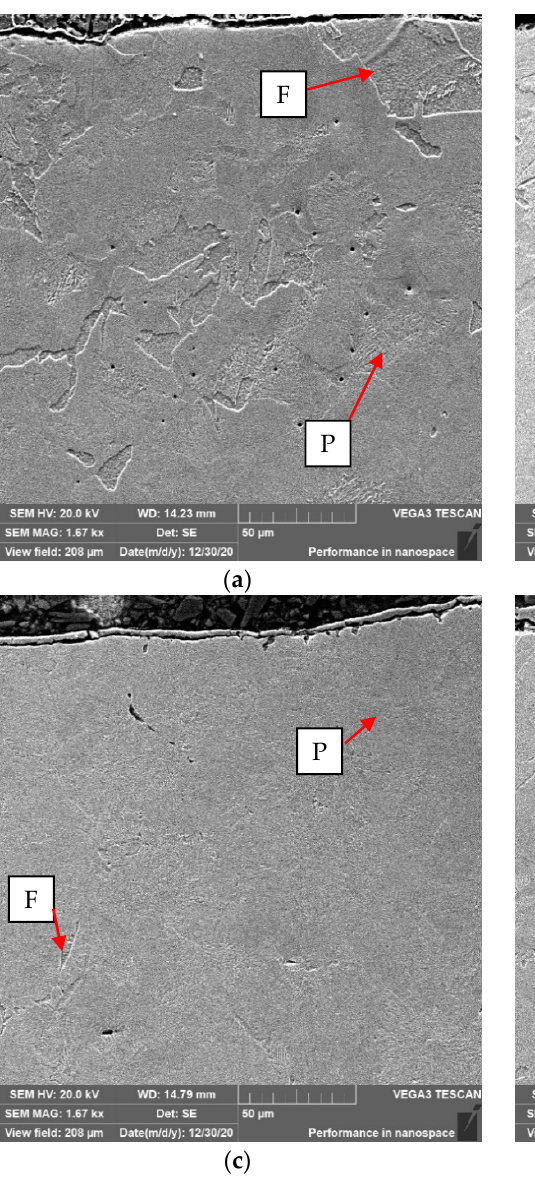
Figure 13. Forging surface—( a ) without the use of protective agents, ( b ) after application of Berulit, ( c ) after application of Bonderite and ( d ) after application of Condursal.